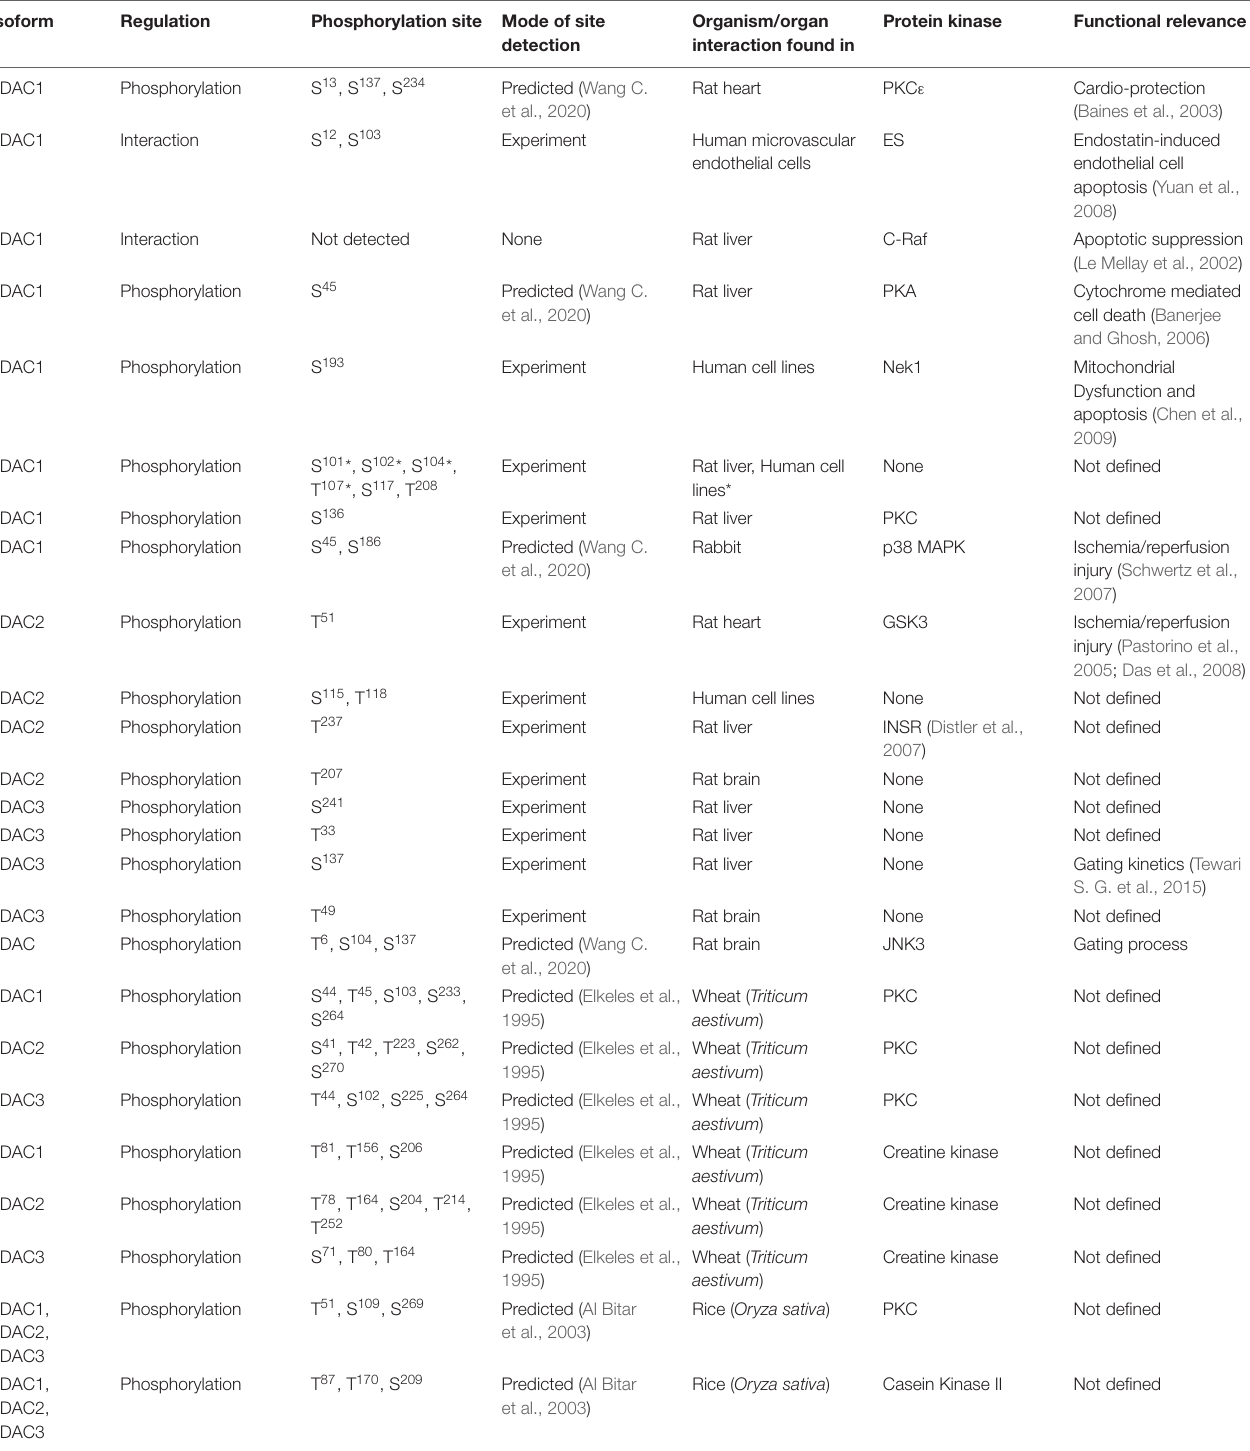
TABLE 1 | The table shows the VDAC isoforms phosphorylated by candidate protein kinases detected by mass spectrometry (MS), site directed mutagenesis (SDM) and predicted sites with their functional consequences.